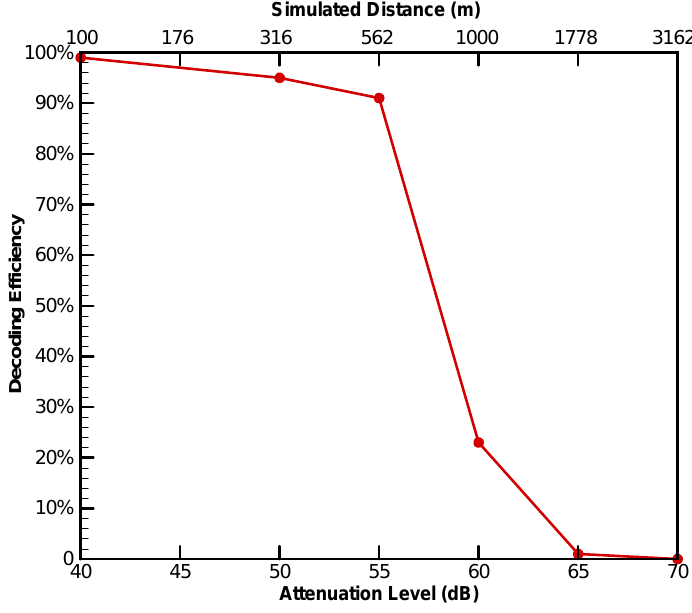
Figure 5. Decoding efficiency for simulated range testing in an ideal environment.